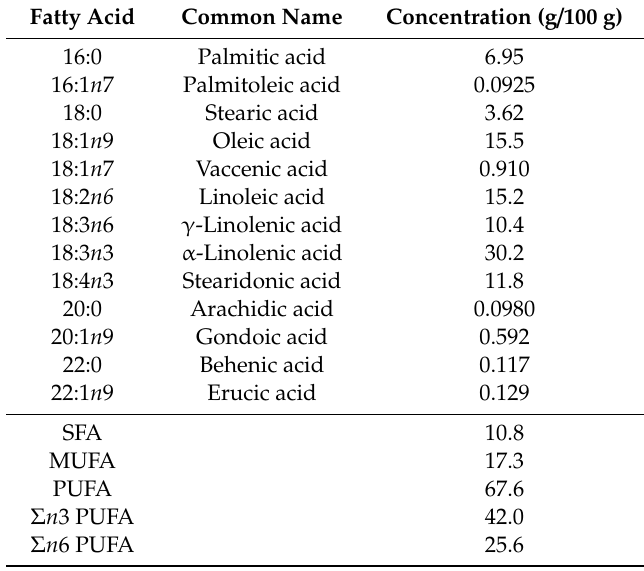
Table 1. Fatty acid pattern (concentration in g / 100 g) of the echium oil used in the study 1 . Fatty Acid Common Name Concentration (g / 100 g) Palmitic